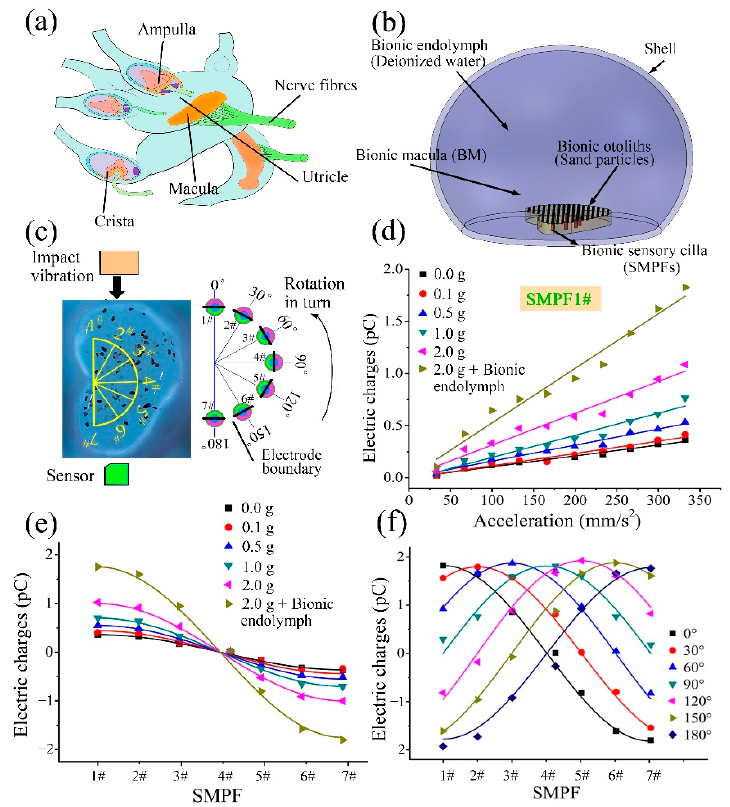
Figure 5. ( a ) A diagram of the structure of the human utricle. ( b ) A diagram of the BMS and the BU. ( c ) A photograph of the BMS and the experimental system. ( d ) The relation between the output charges of the SMPF1# sensor and the linear acceleration of the shell. ( e ) The output charges of the seven SMPF sensors at the same amplitude of impact oscillation. ( f ) The output charges of the seven SMPF sensors at different directions of impact